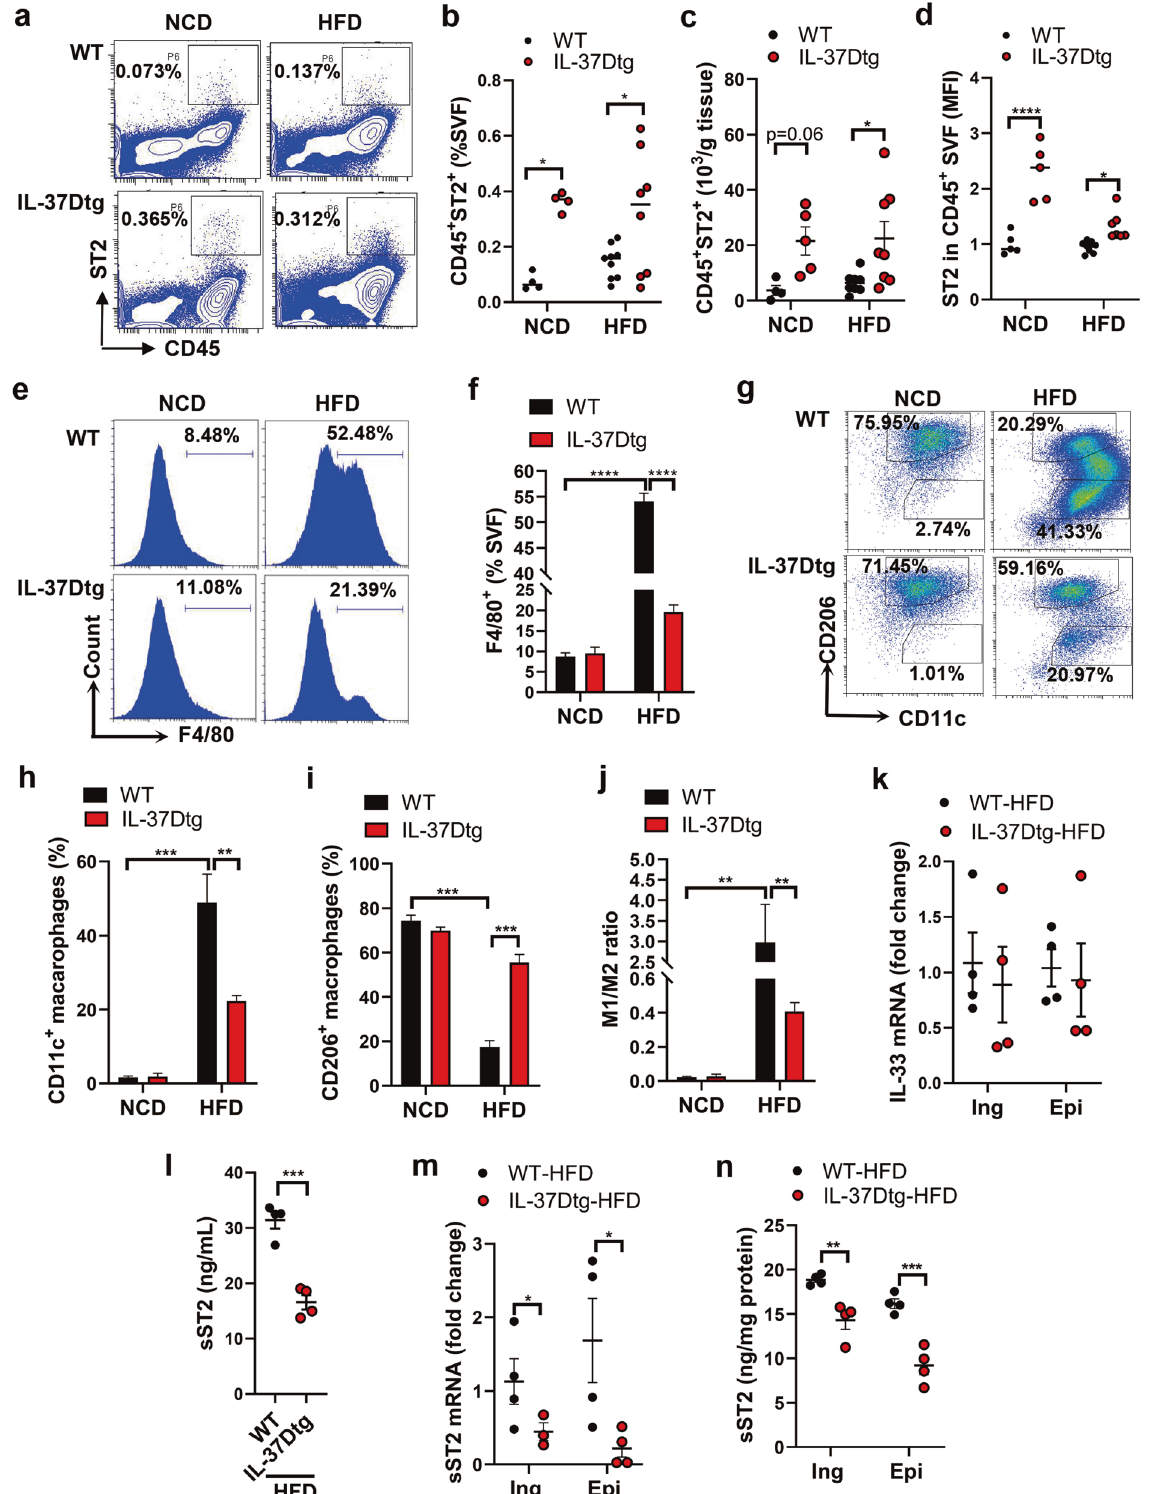
protection against obesity and metabolic disorders by inhibiting sST2 production and enhancing type 2 immune homeostasis in WAT. IL-37D inhibits sST2 production in IL-1R8-dependent manner Since sST2 production can be stimulated by TNF- α via activating NF- κ B pathway [17], we further examined the in fl uence of IL-37D